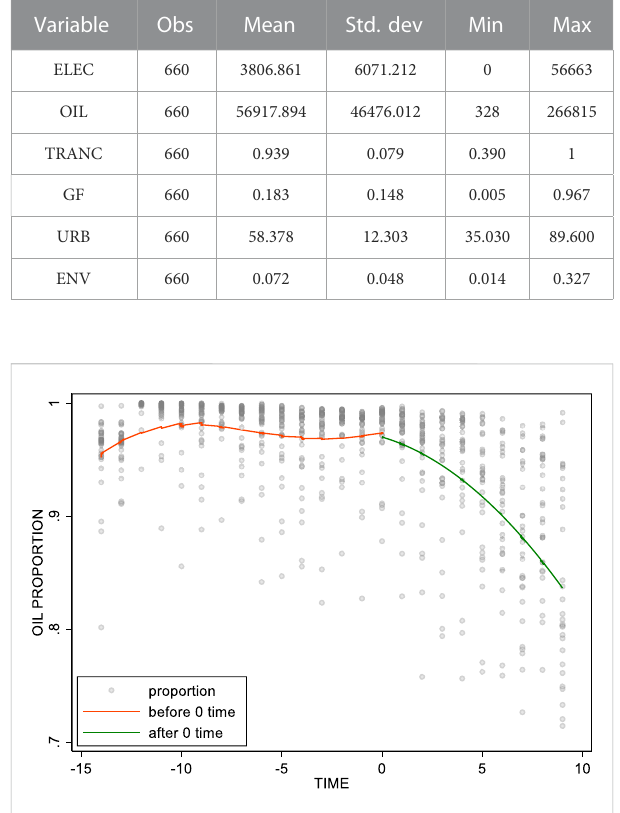
FIGURE 1 Relationship between COVID-19 pandemic shock and the share of traditional automobile